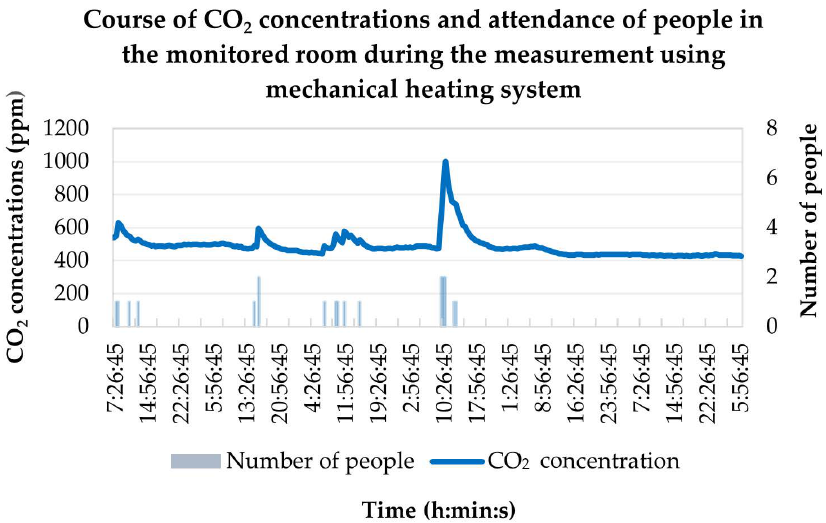
Figure 11. Course of CO 2 concentrations and attendance of people in the monitored room during the measurement using